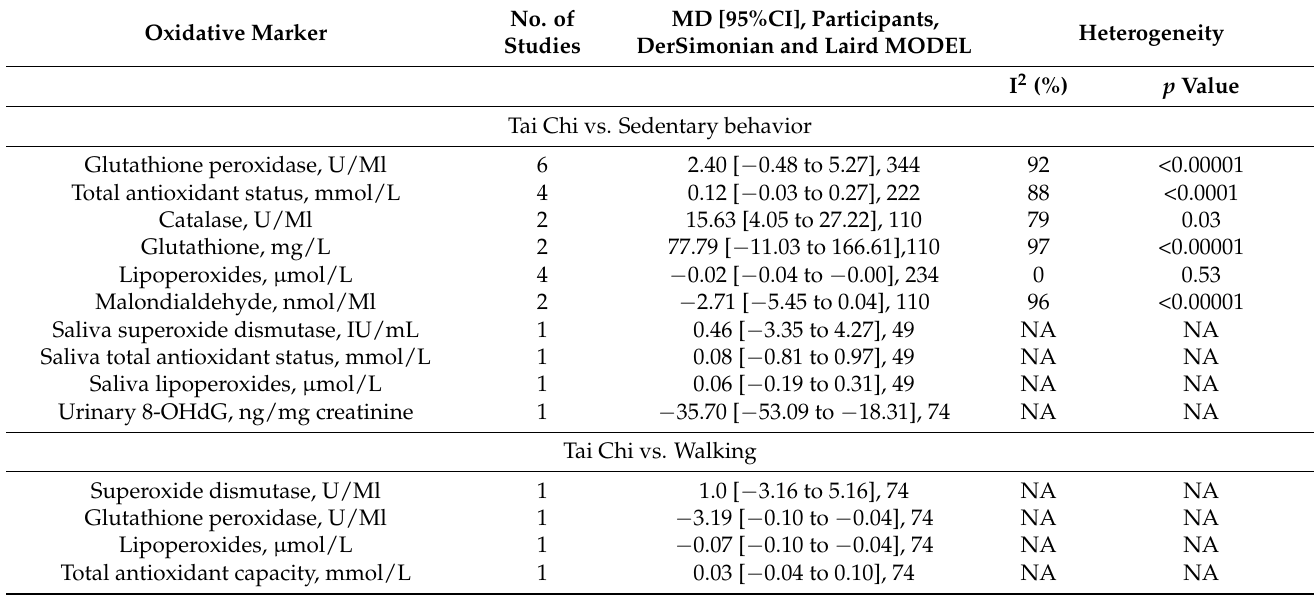
Table 2. Pooled mean difference in oxidative stress